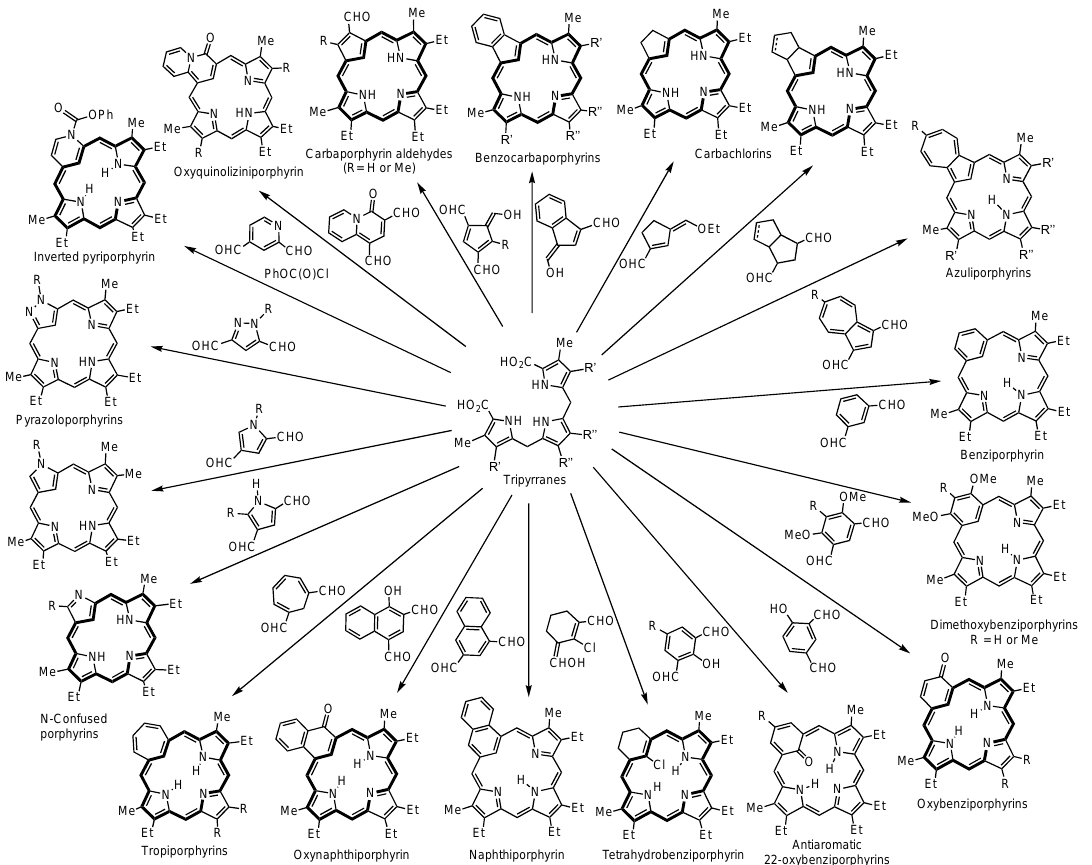
Scheme 4. Synthesis of carbaporphyrinoid systems using MacDonald- type ‘3 + 1’